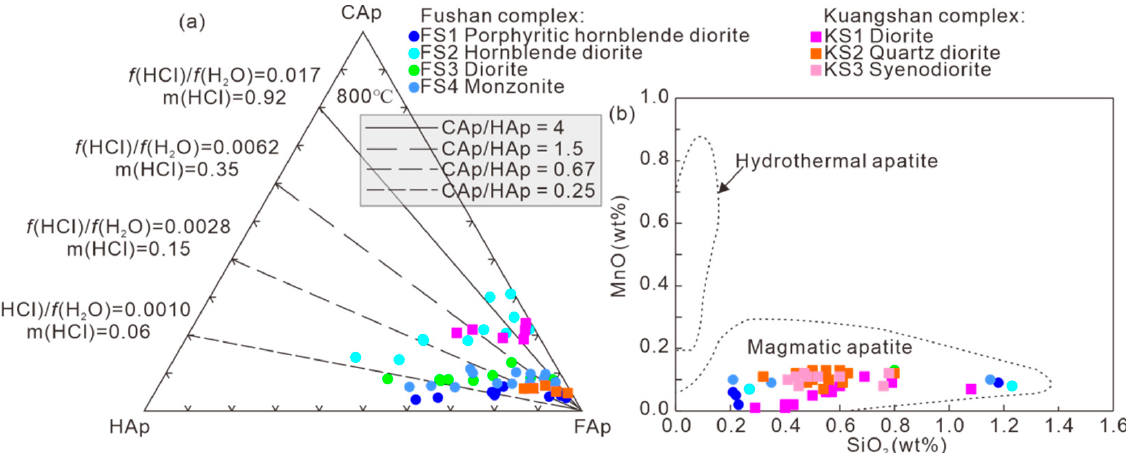
Figure 6. ( a ) Plot of composition of the halogen site in apatite with lines of constant Cl/OH (molar) in apatite (revised from [69,70]). ( b ) SiO 2 -MnO discriminant diagram of apatite type (revised from [71]). Abbreviations: FS = Fushan complex, KS = Kuangshan complex.